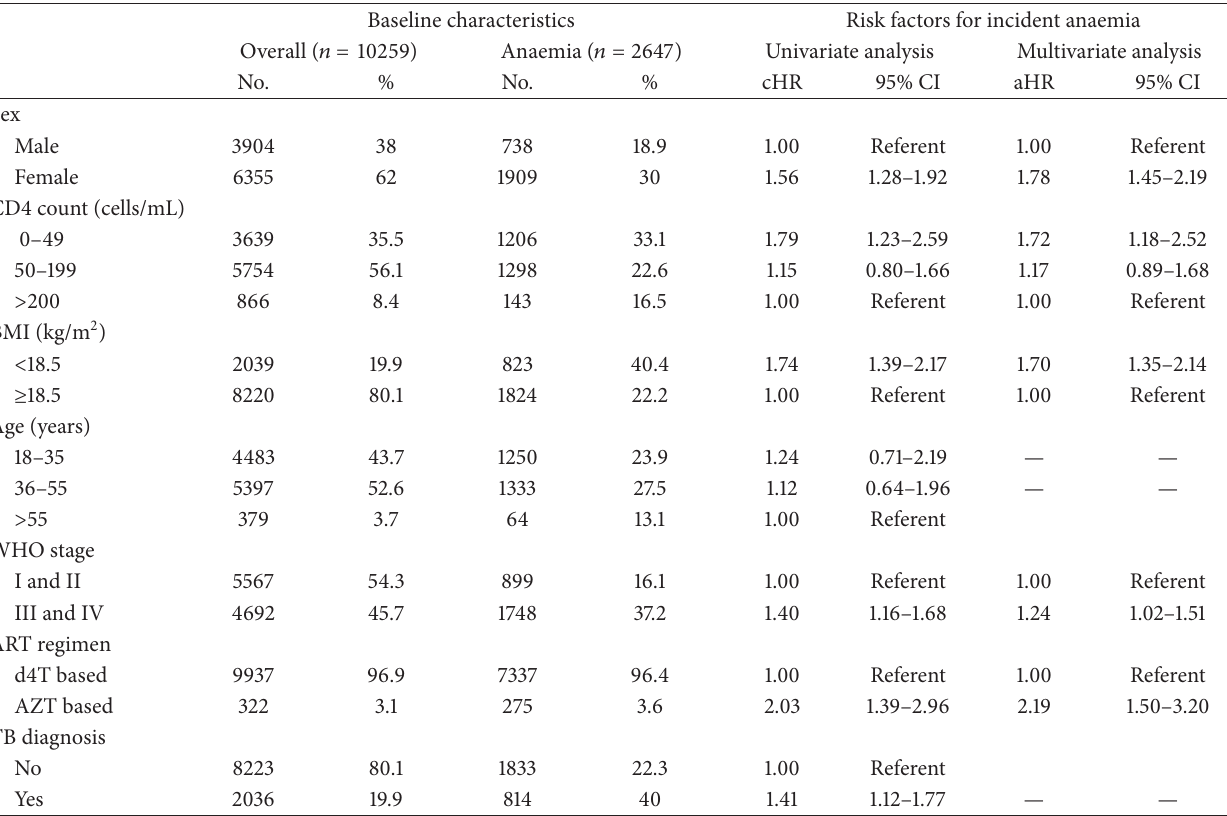
Table 1: Baseline characteristics among patients initiating first-line ART and the risk factors for incident anemia at the Themba Lethu Clinic in Johannesburg, South